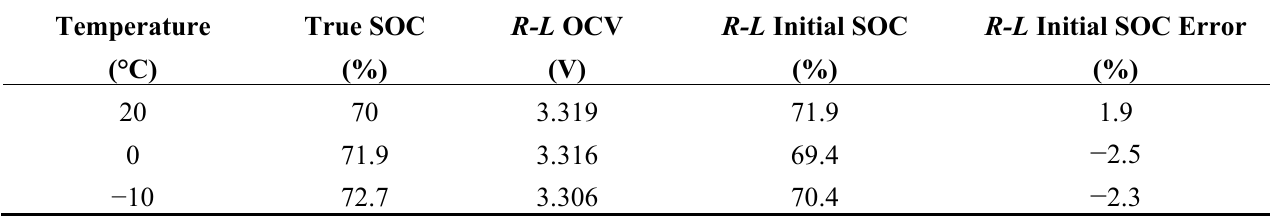
Table 7. The R-L non-rated initial SOC and SOC error at 20, 0, and − 10 °C (point 1).